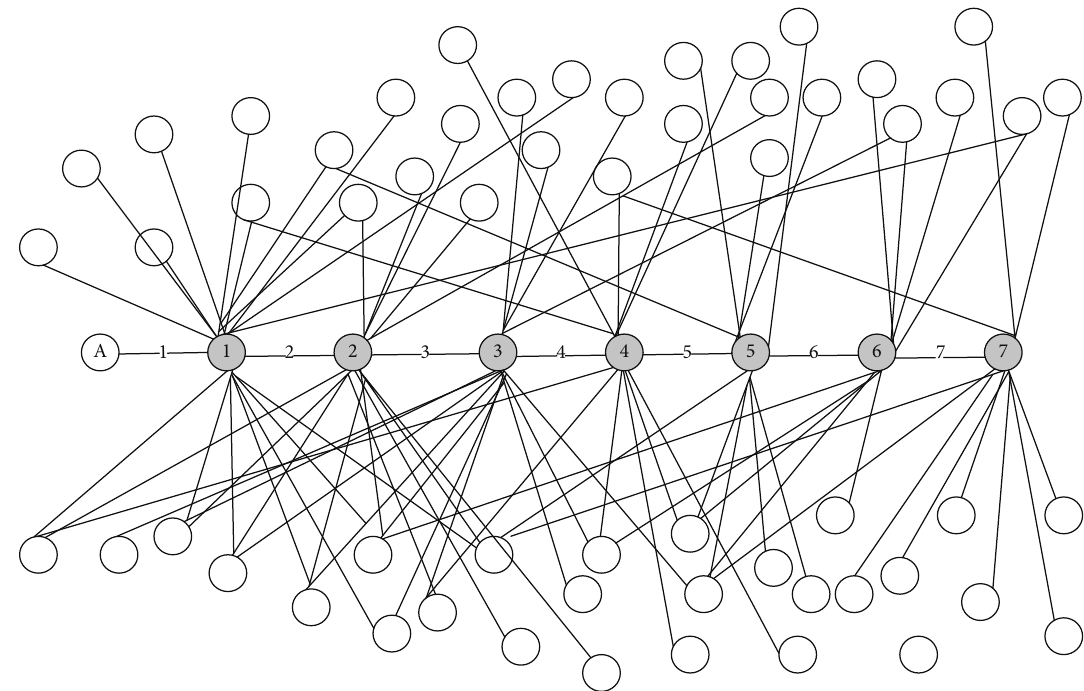
Figure 6: Schematic diagram of the six-dimensional space